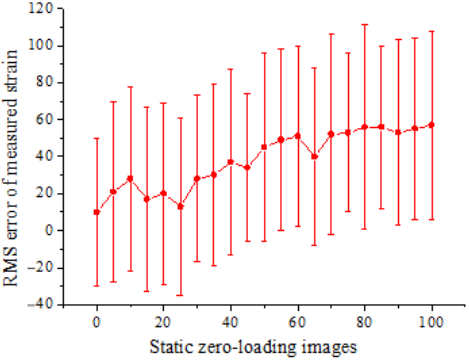
Figure 10. RMS error of strain computed from the static undeformed beam.